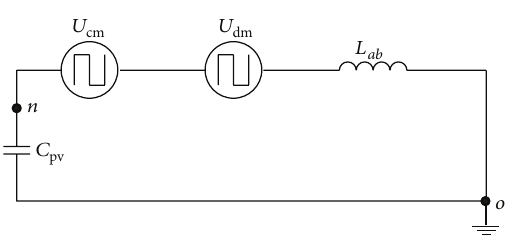
Figure 2: System’s common mode model